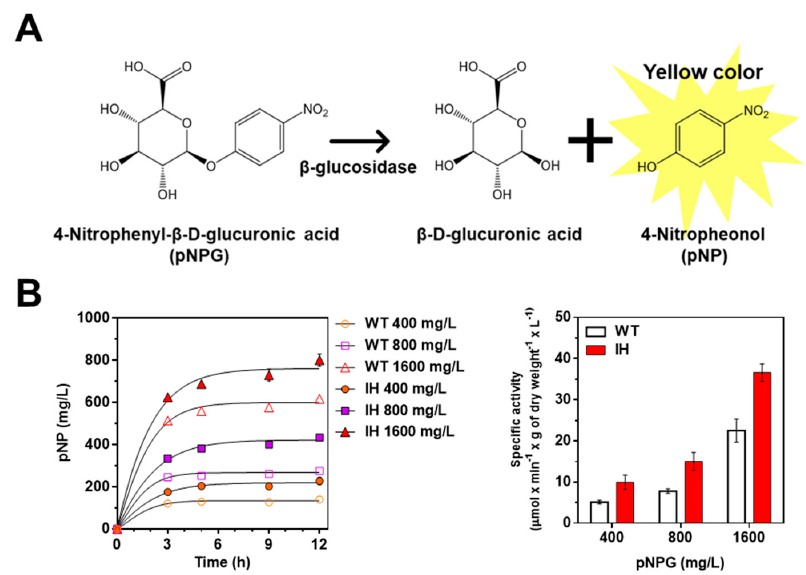
Figure 3. Identification of enzymatic activity of IH via in vivo β -glucosidase activity assay. ( A ) Schematic of reaction mechanism of β -glucosidase assay. ( B ) β -glucosidase activity of L. citreum wild type and L. citreum harboring pCB4270V4-IH in MRS medium supplemented with different concentrations of pNPG. The pNP production was measured at different culture times. Left, time profiles of pNP production; right, normalized specific activity of β -glucosidase activity of L. citreum wild type and L. citreum harboring pCB4270V4-IH at 12 h. WT represents L. citreum wild type and IH represents L. citreum harboring pCB4270V4-IH. Results are the mean of duplicate experiments, and error bars indicate standard Table 1. Summary of in vivo β -glucosidase activity in L. citreum harboring pCB4270V4-IH. Strain